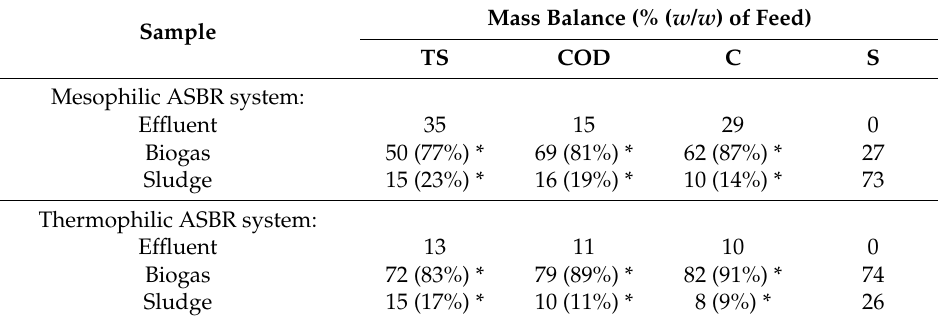
Table 4. The mass balance for the ASBR operated under a mesophilic or thermophilic temperature under steady state conditions at the optimum COD loading rates of 6 and 10 kg/m 3 d, respectively (with S.D. less than 5%). Mass Balance (% ( w / w ) of Feed) Sample TS COD C